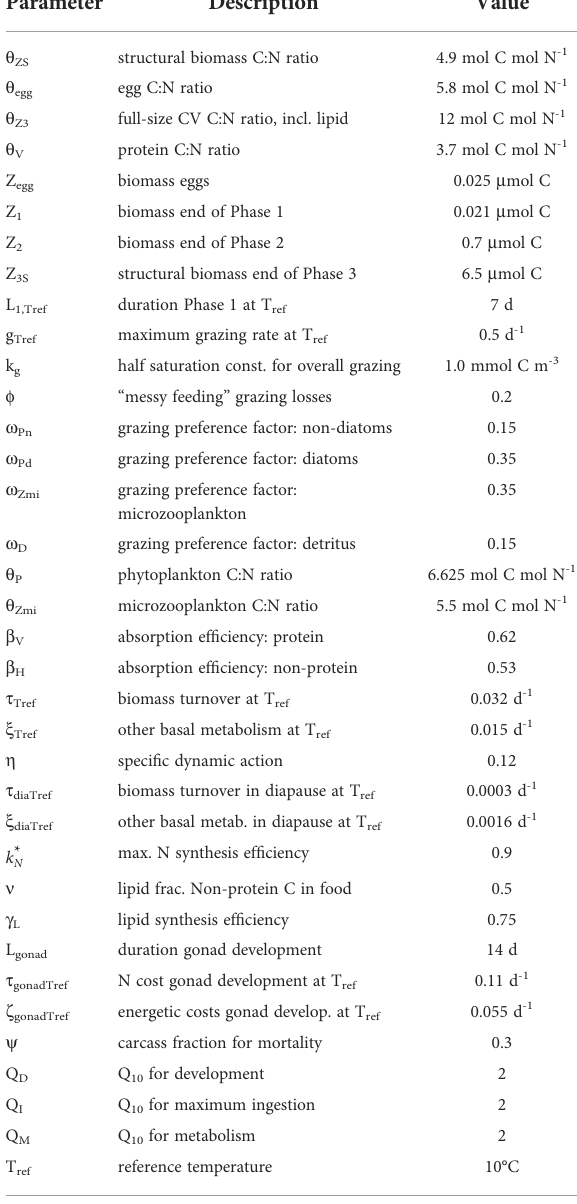
TABLE 1 Model parameters.